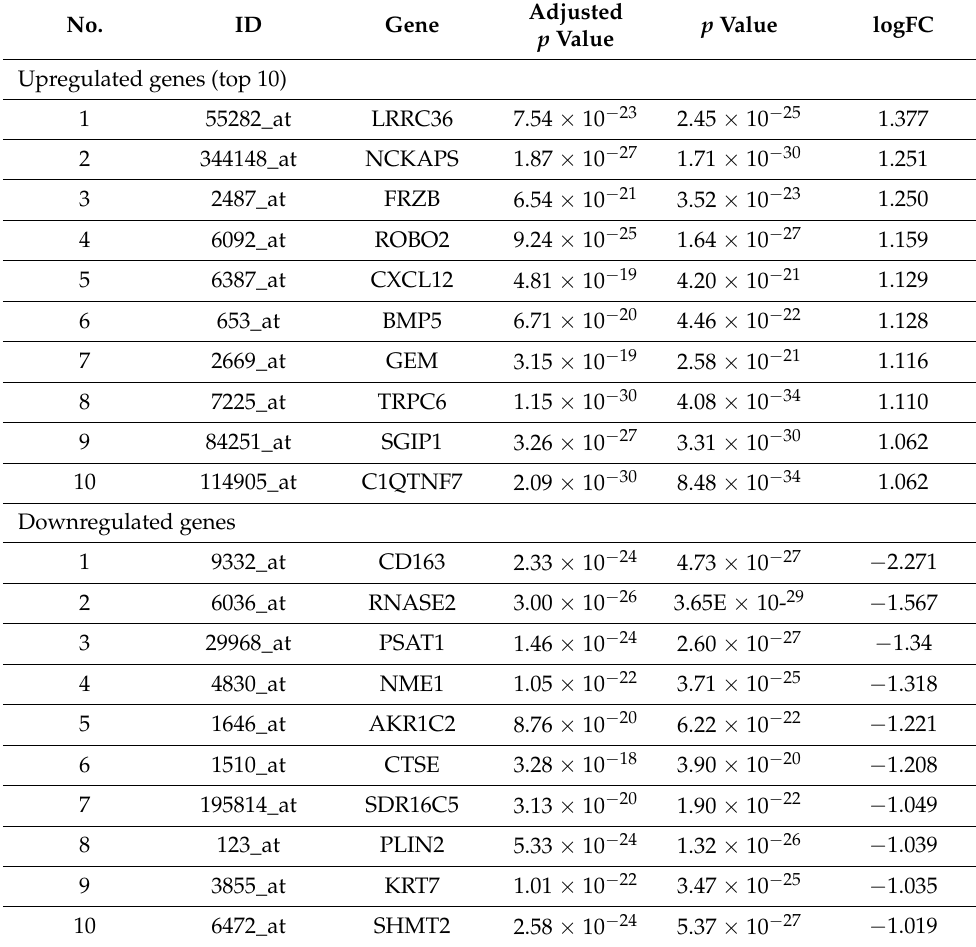
Table 2. List of differentially expressed total RNAs using GEO2R.